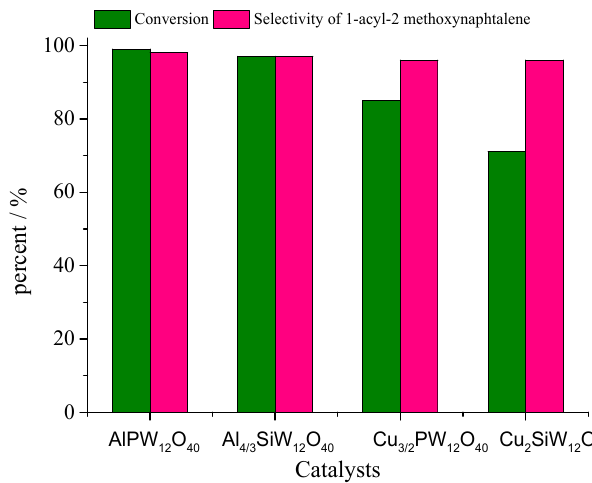
Figure 9. 2-Methoxynaphthalene acylation using aluminium or copper salts of phosphotungstic silicotungstic acids as catalysts (adapted from ref. [39]) a . a Reaction conditions: time: 65 min, temperature: 373 K.